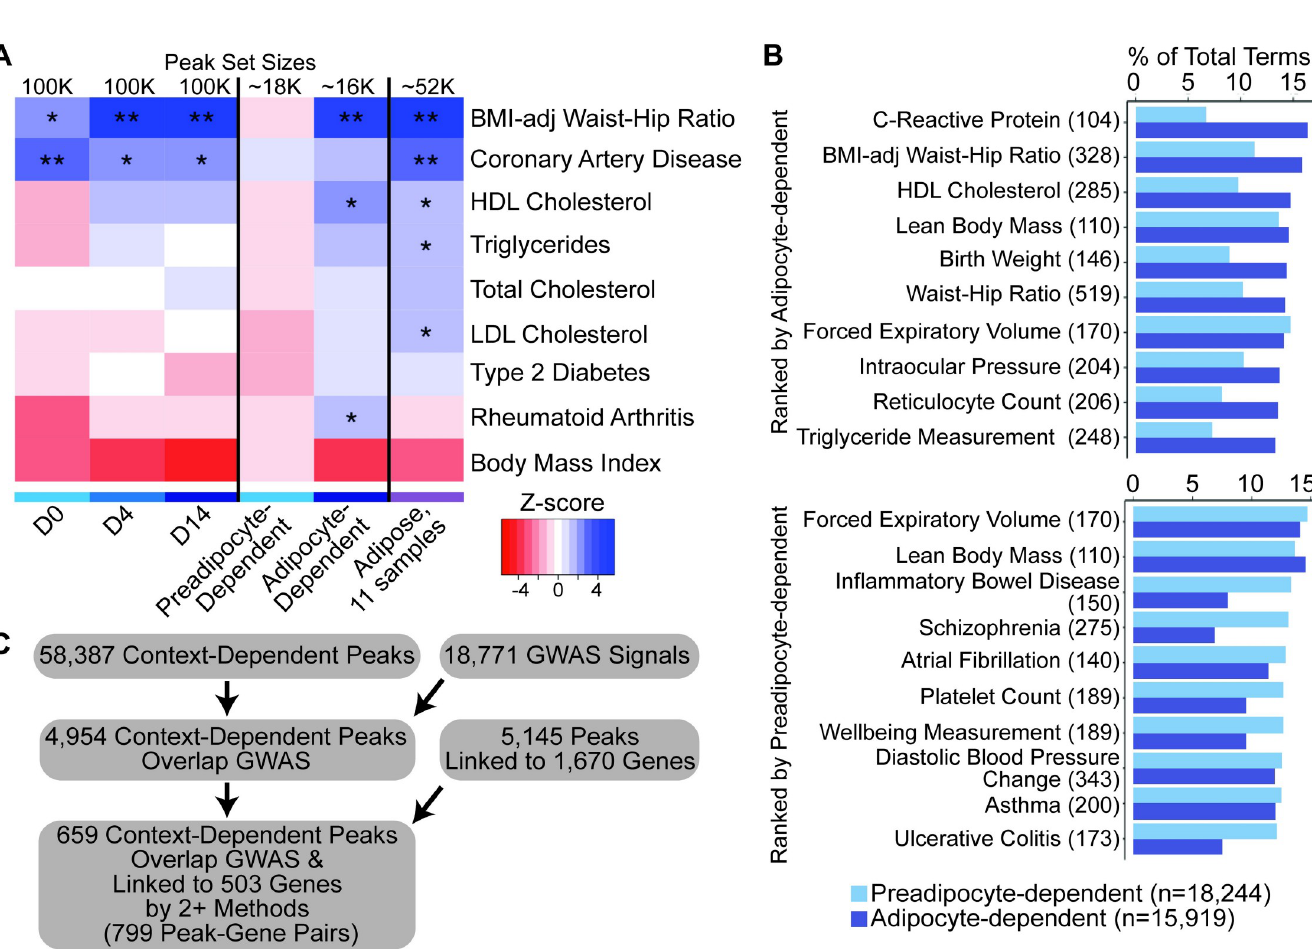
Fig 3. Linking peaks to GWAS signals. (A) Heatmap of cardiometabolic trait GWAS locus enrichment; rheumatoid arthritis was selected for comparison. Peak sets include 100,000 peaks from individual days, preadipocyte- and adipocyte-dependent peaks derived from pairs of timepoints, and adipose tissue peaks. Values in S13 Table. �� , P < 0.0056; � , P < 0.05 (B) Barplots of normalized counts of specific experimental factor ontology (EFO) terms for GWAS signals with a variant in a context- dependent peak. Barplots show the top ten EFO terms ranked by normalized count for either preadipocyte-dependent peaks, or adipocyte-dependent peaks. Total number of signals for each term used in the overlap is noted in parentheses in the axis label. Total number of signals for each term overlapping a context-dependent peak is noted to the right of the “All Context-dependent” bar. Values in S14 Table. (C) Flowchart identifying context-dependent peaks overlapping GWAS signals and linked to genes through 2 or more